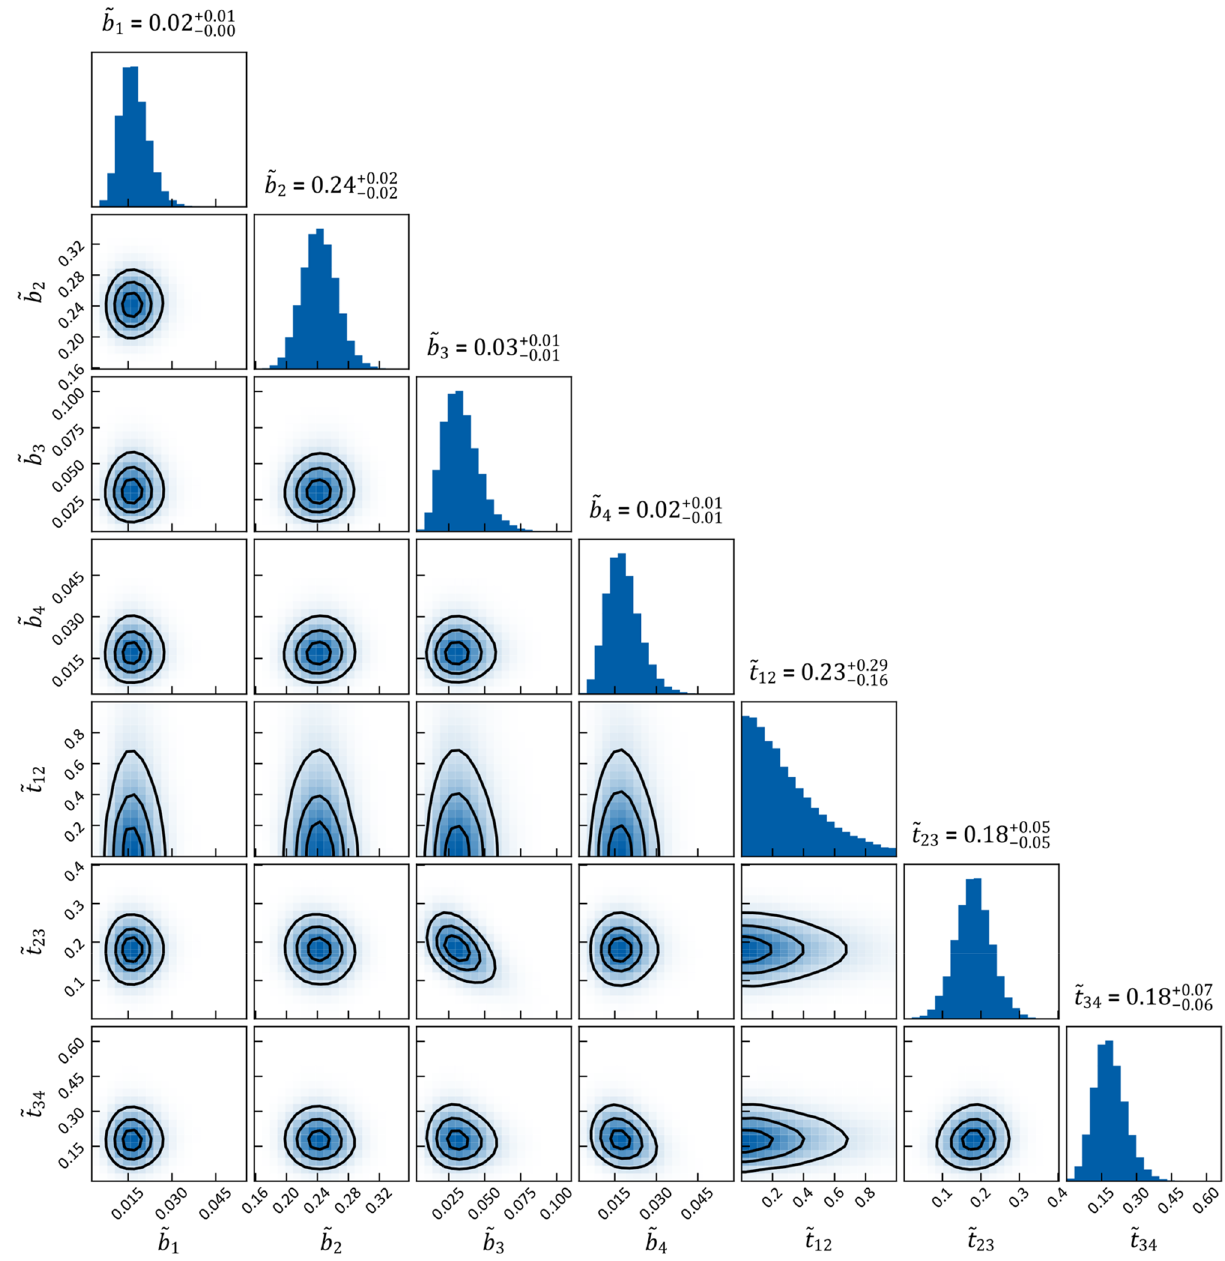
Figure 5. Corner plot of the sampled parameters for the HMM model parameters. The histograms on the diagonal show the 1D marginals, while the lower triangle shows all possible combinations of 2D marginals. The black lines are the isolines enclosing 20%, 50% and 80% of the sampled points respectively. Correlations between the parameters can at most be seen between ˜ t 23 and ˜ b 3